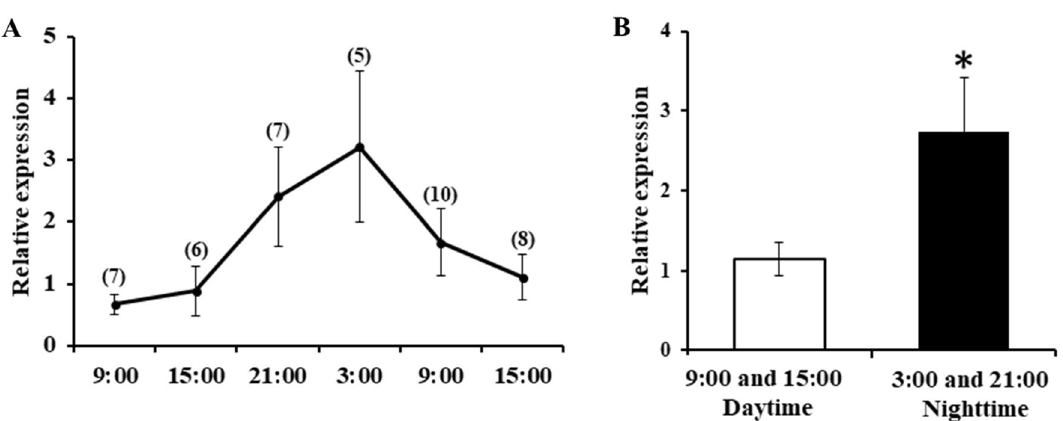
Figure 10. mRNA expression profiles of neuropsin in Oligobrachia mashikoi . ( A ) Beard worms were collected from the seabed every 6 h; ( B ) expression levels of neuropsin mRNA during daytime (9:00 and 15:00) and nighttime (21:00 and 3:00). The statistical significance between the daytime and nighttime groups was assessed using an independent sample t -test. The number of individuals at each hour is shown in parentheses. *p <